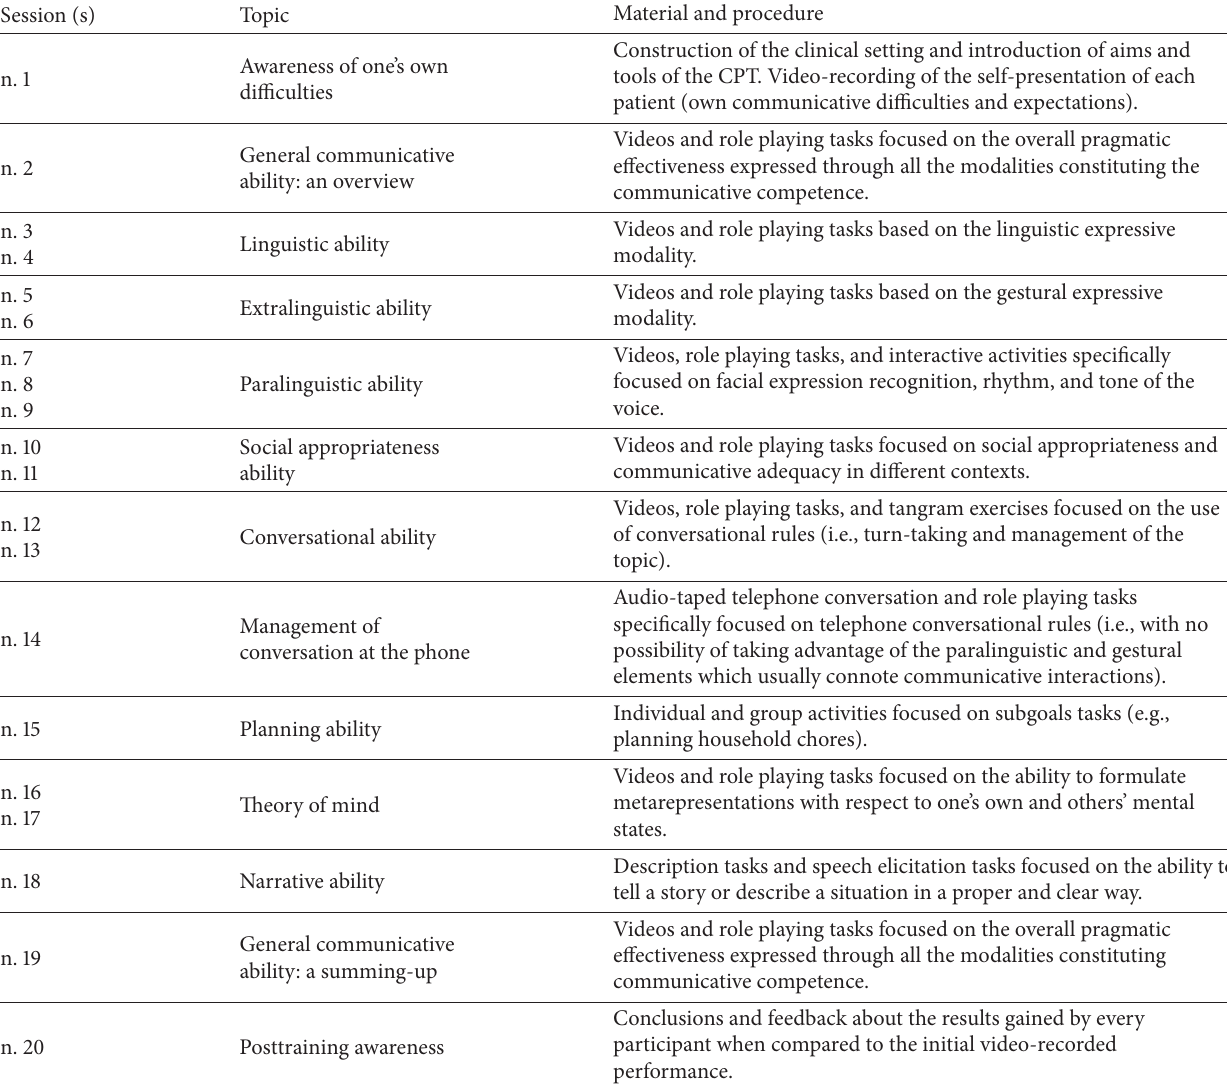
Table 1: Structure of the Cognitive Pragmatic Treatment: topics, material, and procedures belonging to each session. Material and